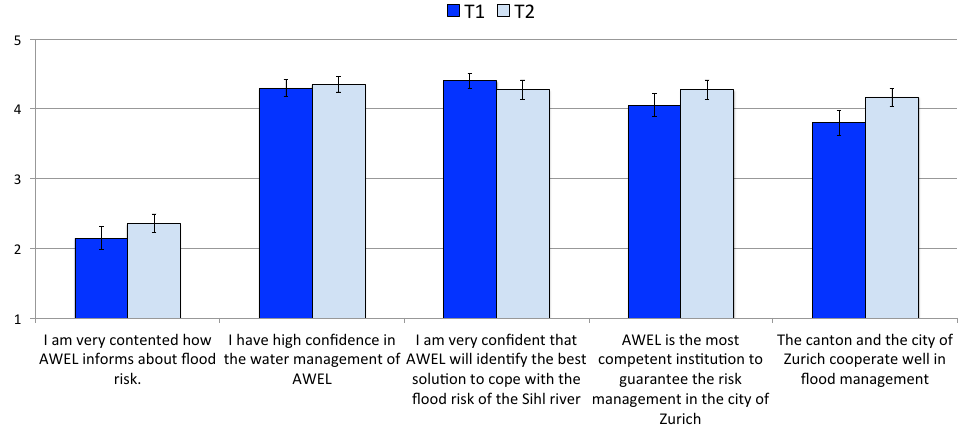
Fig. 7. Effects on trust in the risk management before (T1) and after (T2) the participatory assessment process